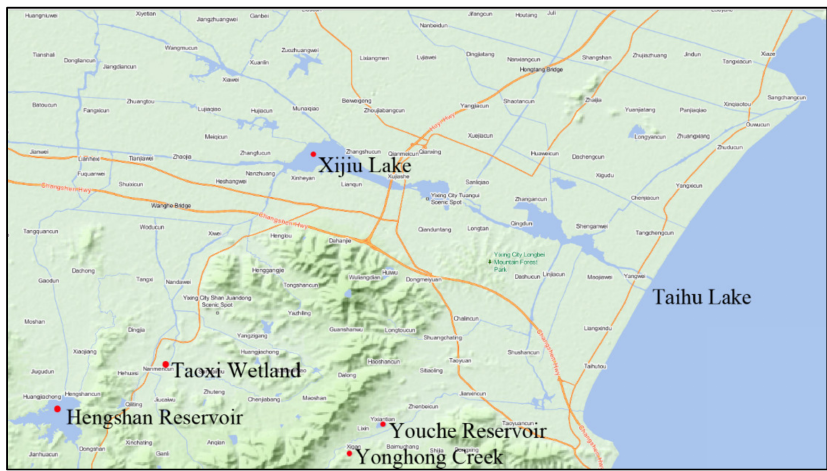
Figure 5. Current and future drinking water sources in reservoirs in Yixing